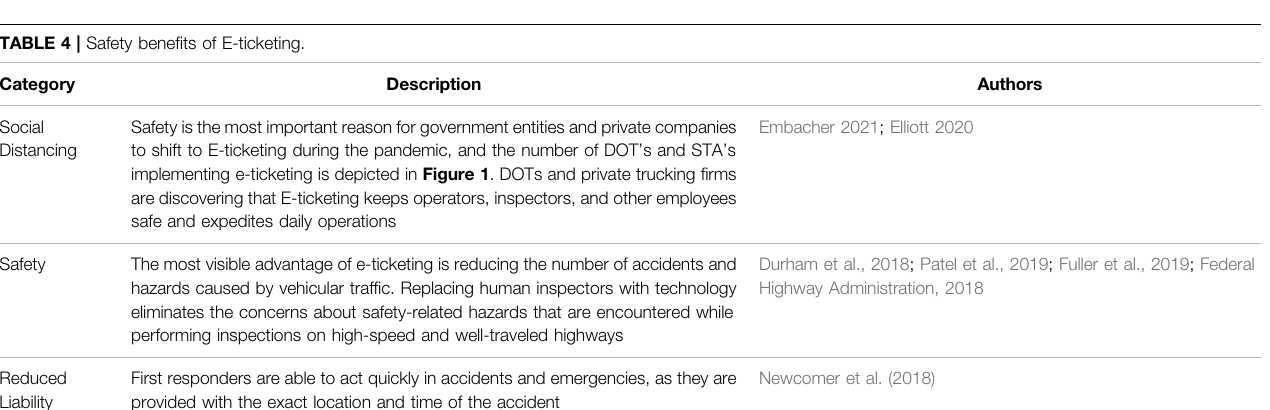
TABLE 4 | Safety bene fi ts of